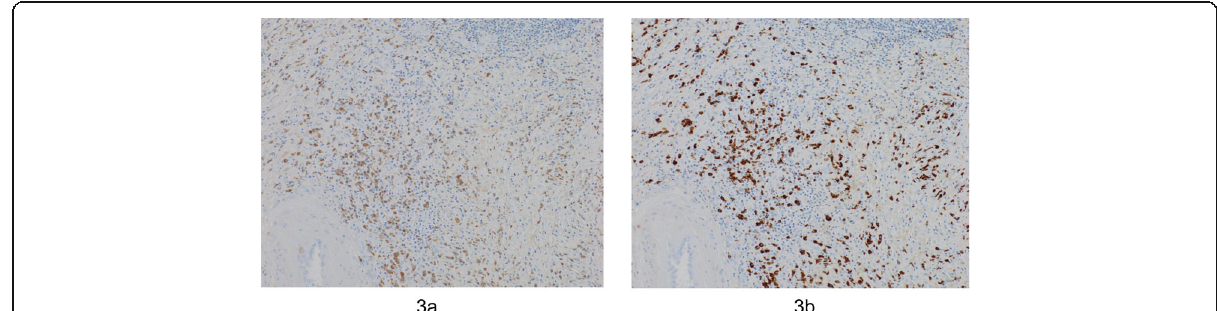
Fig. 3 Histopathological findings show lymphoplasmacytic infiltration and fibrosis ( a ). Immunohistochemical findings show infiltration of IgG4- positive lymphoplasmacytic cells ( b